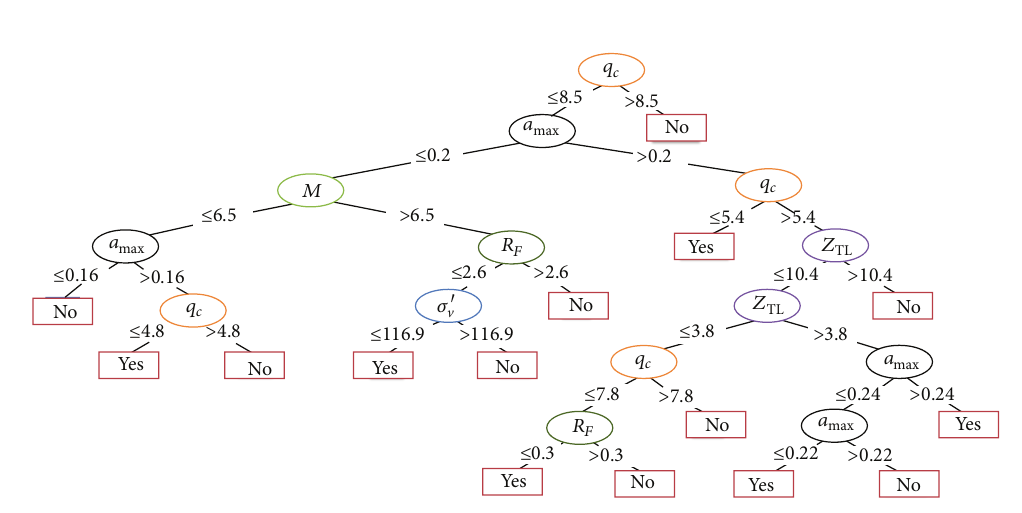
Figure 21: CLIP: Geotechnical description 𝑉 𝑠 .